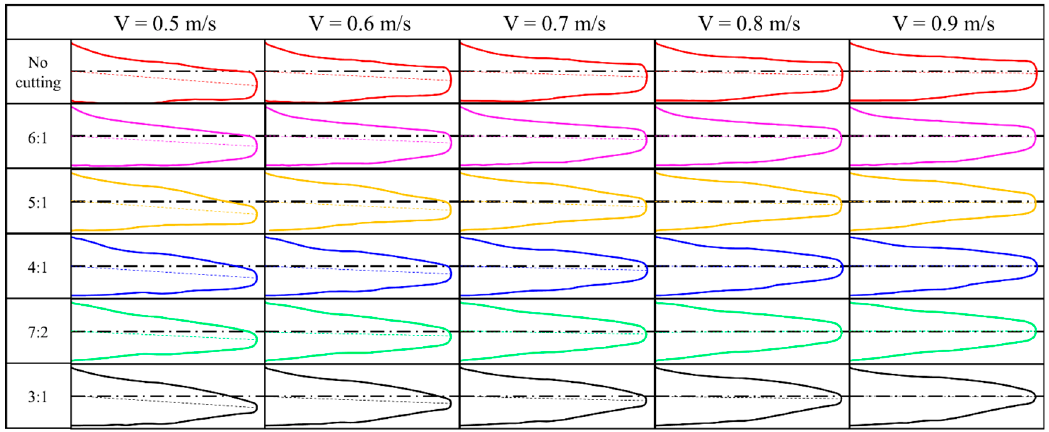
Figure 5. Variation of the profile of empty codends with different cutting ratios at different current speeds.